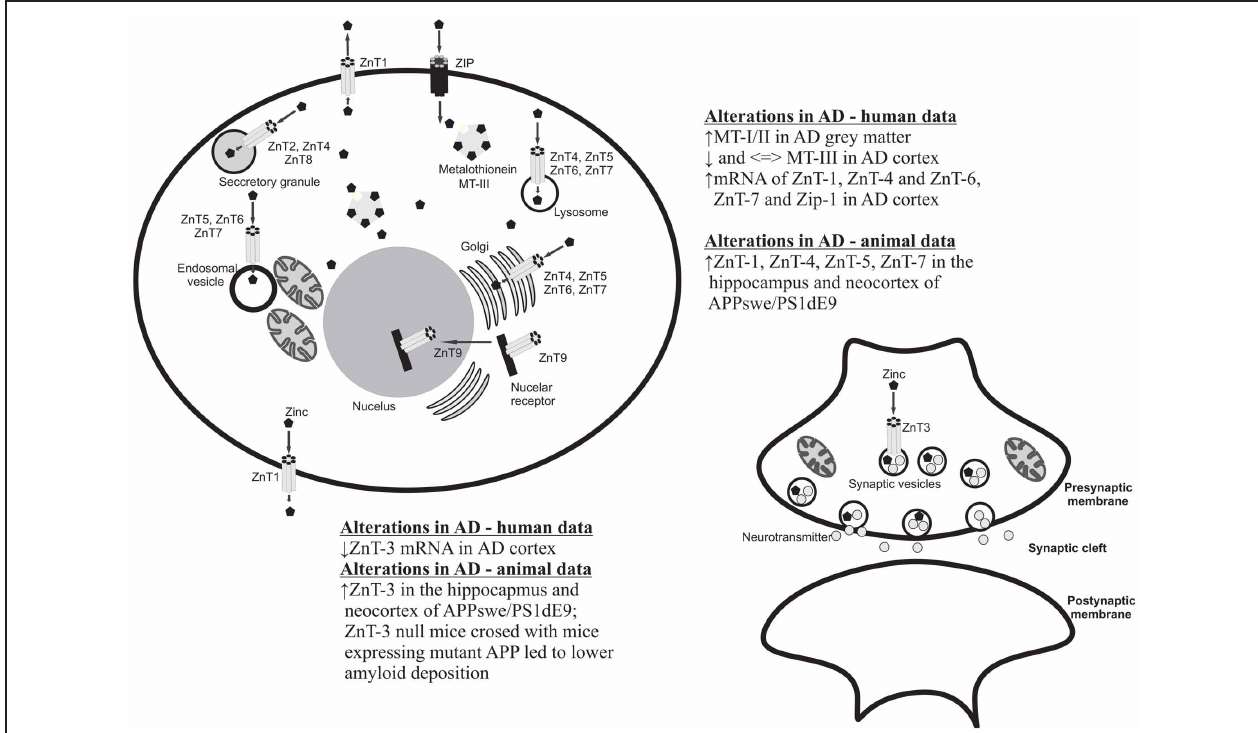
FIGURE 1 | Cellular localization of zinc transporters and metallothioneins and summary of the main clinical and preclinical findings supporting the involvement of these proteins in AD.